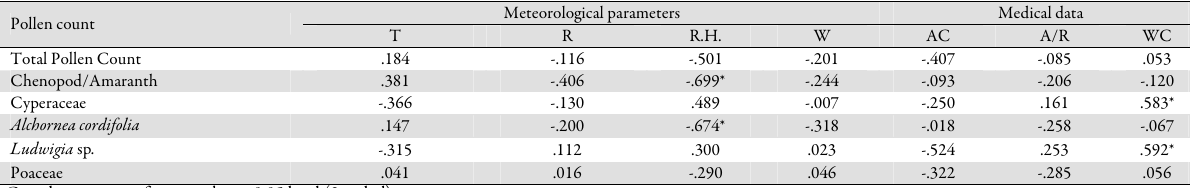
Tab. 2. Correlation coefficients between pollen counts, meteorological parameters and medical